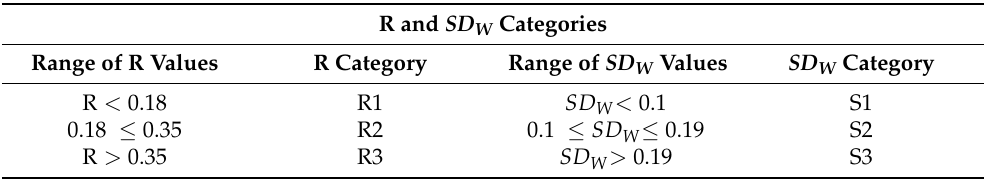
Figure 9. R and S definitions. The probability density functions (PDF) for the R metric ( A ) and the ( B ) SD W metric. The x axis represents the range of R or SD W . Three sections in each PDF graph have been identified by determining the spread from the mean. If a value falls within a range, it is given that range’s label. Table 1. R and SD W ranges for category assignment. Values are determined by the mean and standard deviation of the log normal distribution for each of the variables (Figure 8).